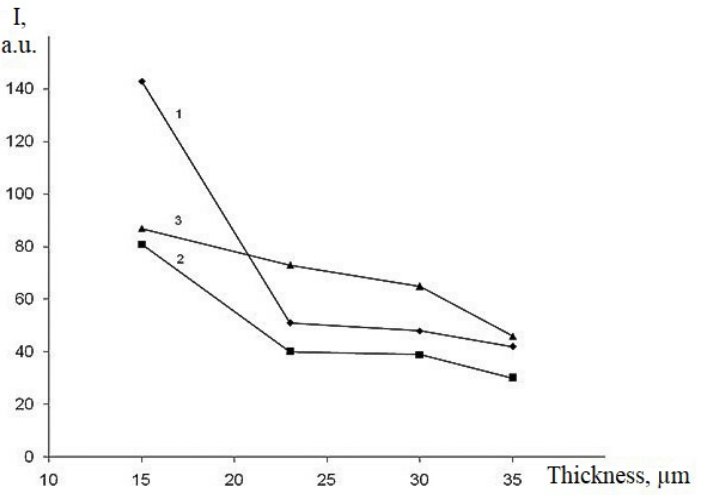
Figure 5. Profiles of the concentration of nickel (1), chromium (2) and carbon (3) in the nickel– chromium–GO composite coating obtained at cathodic current density i C = 10 A/dm 2 .